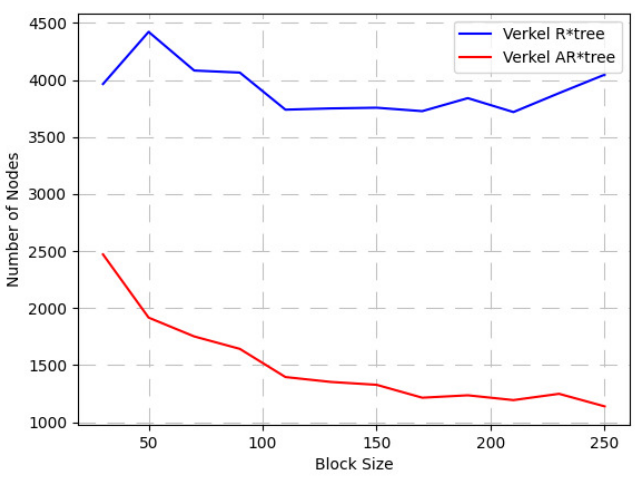
Figure 9. The number of node accesses of the two algorithms under different block sizes. However, the performance of adaptive Verkle AR*-tree is greatly affected by query distribution and max children size of the node. We design seven sampling methods for the query